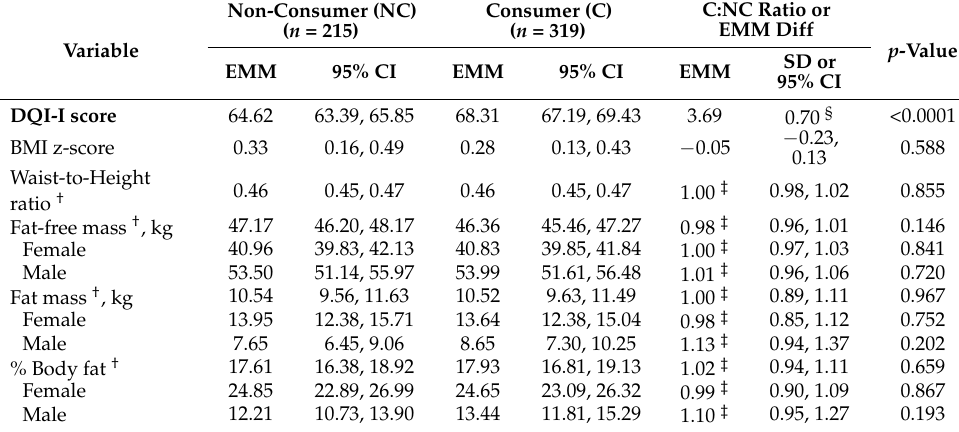
Table 4. Comparison * of Dietary Quality Index-International (DQI-I) score and anthropometric parameters between avocado consumers and non-consumers after controlling for confounders.